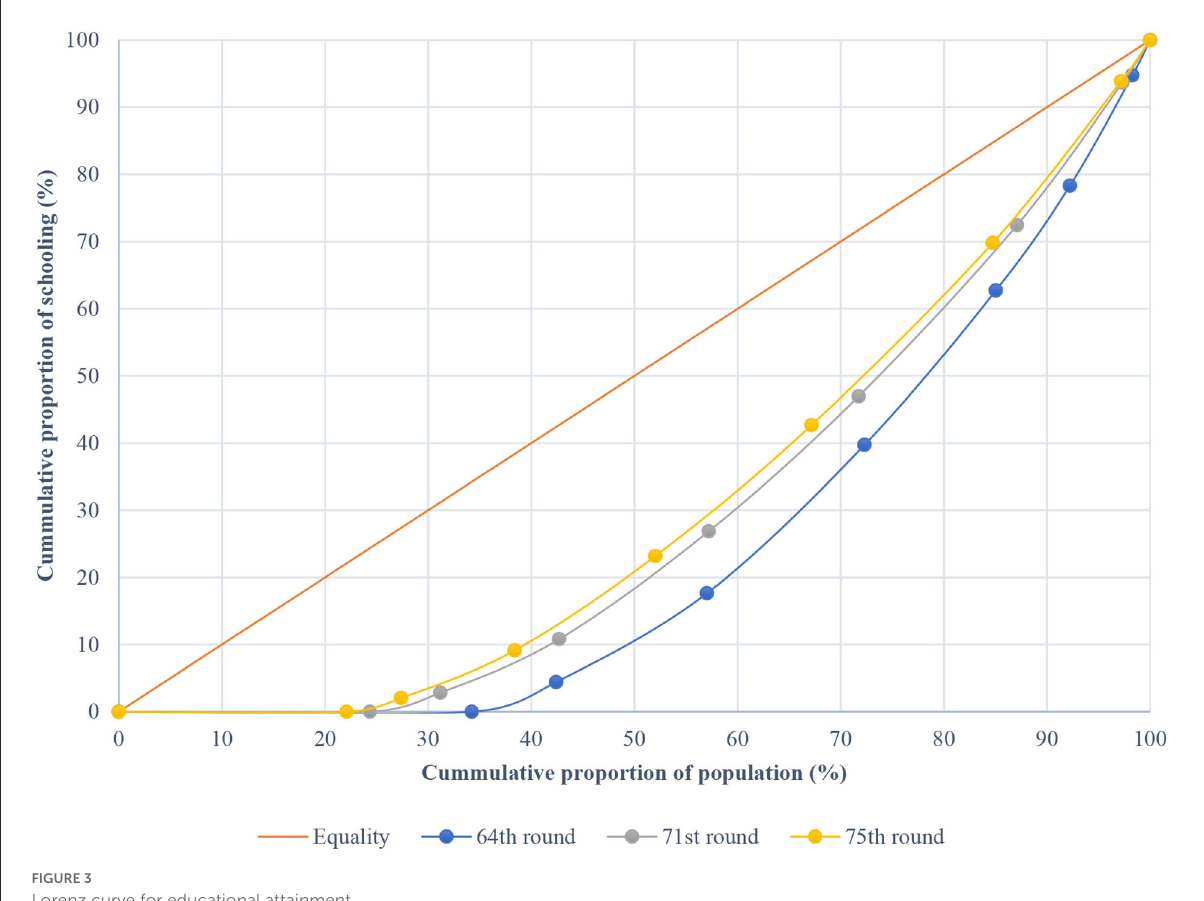
FIGURE3 Lorenz curve for educational